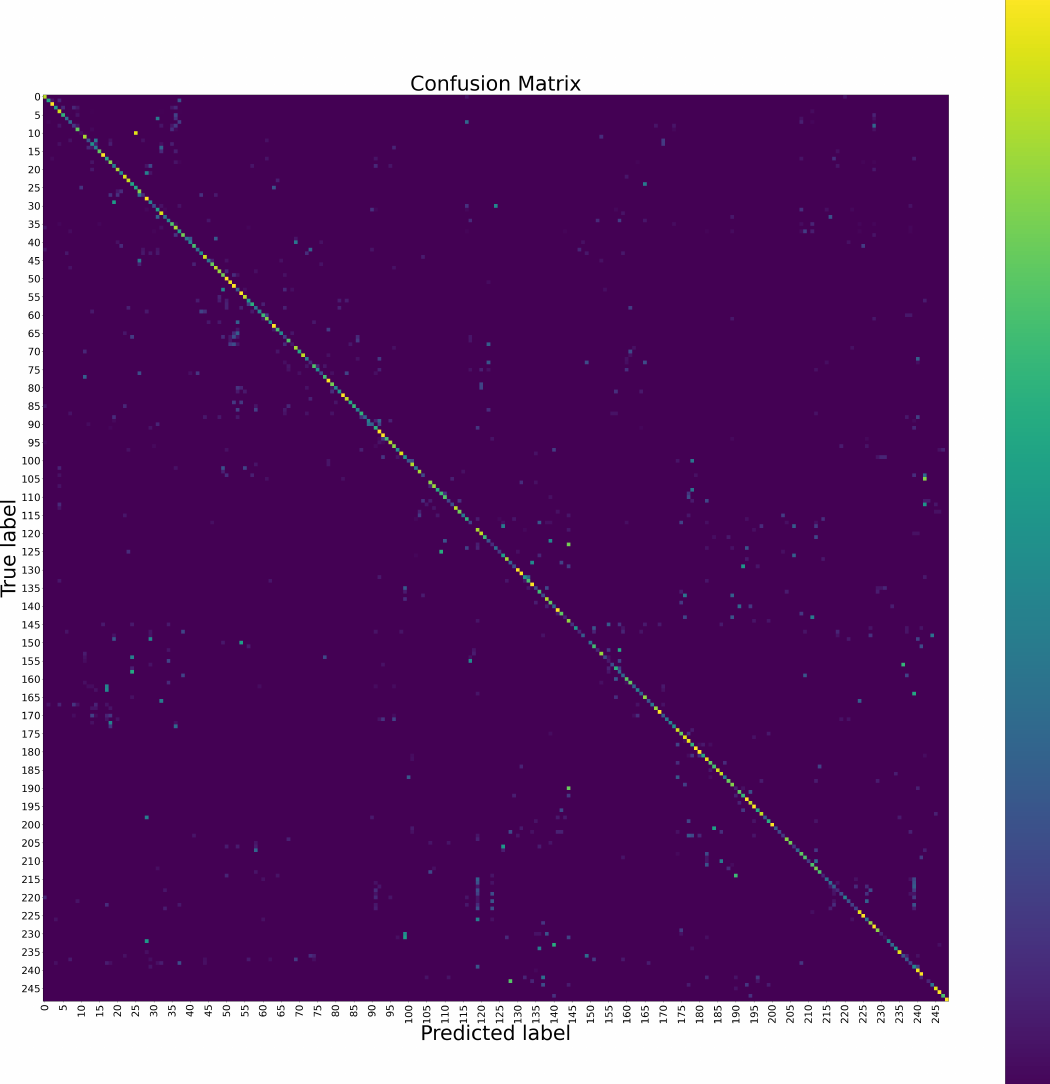
Figure 4. The confusion matrix of the proposed method at the hand level on the Chalearn LAP IsoGD dataset. To see the details, please zoom